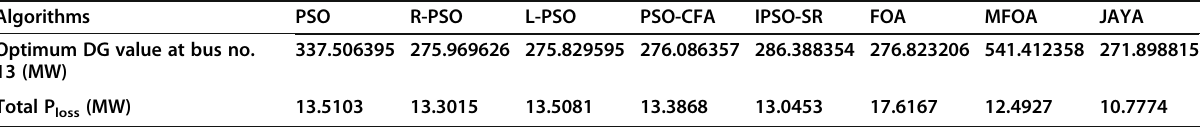
Table 21 Simulation results on IEEE 57 bus system with DG using different algorithms Algorithms